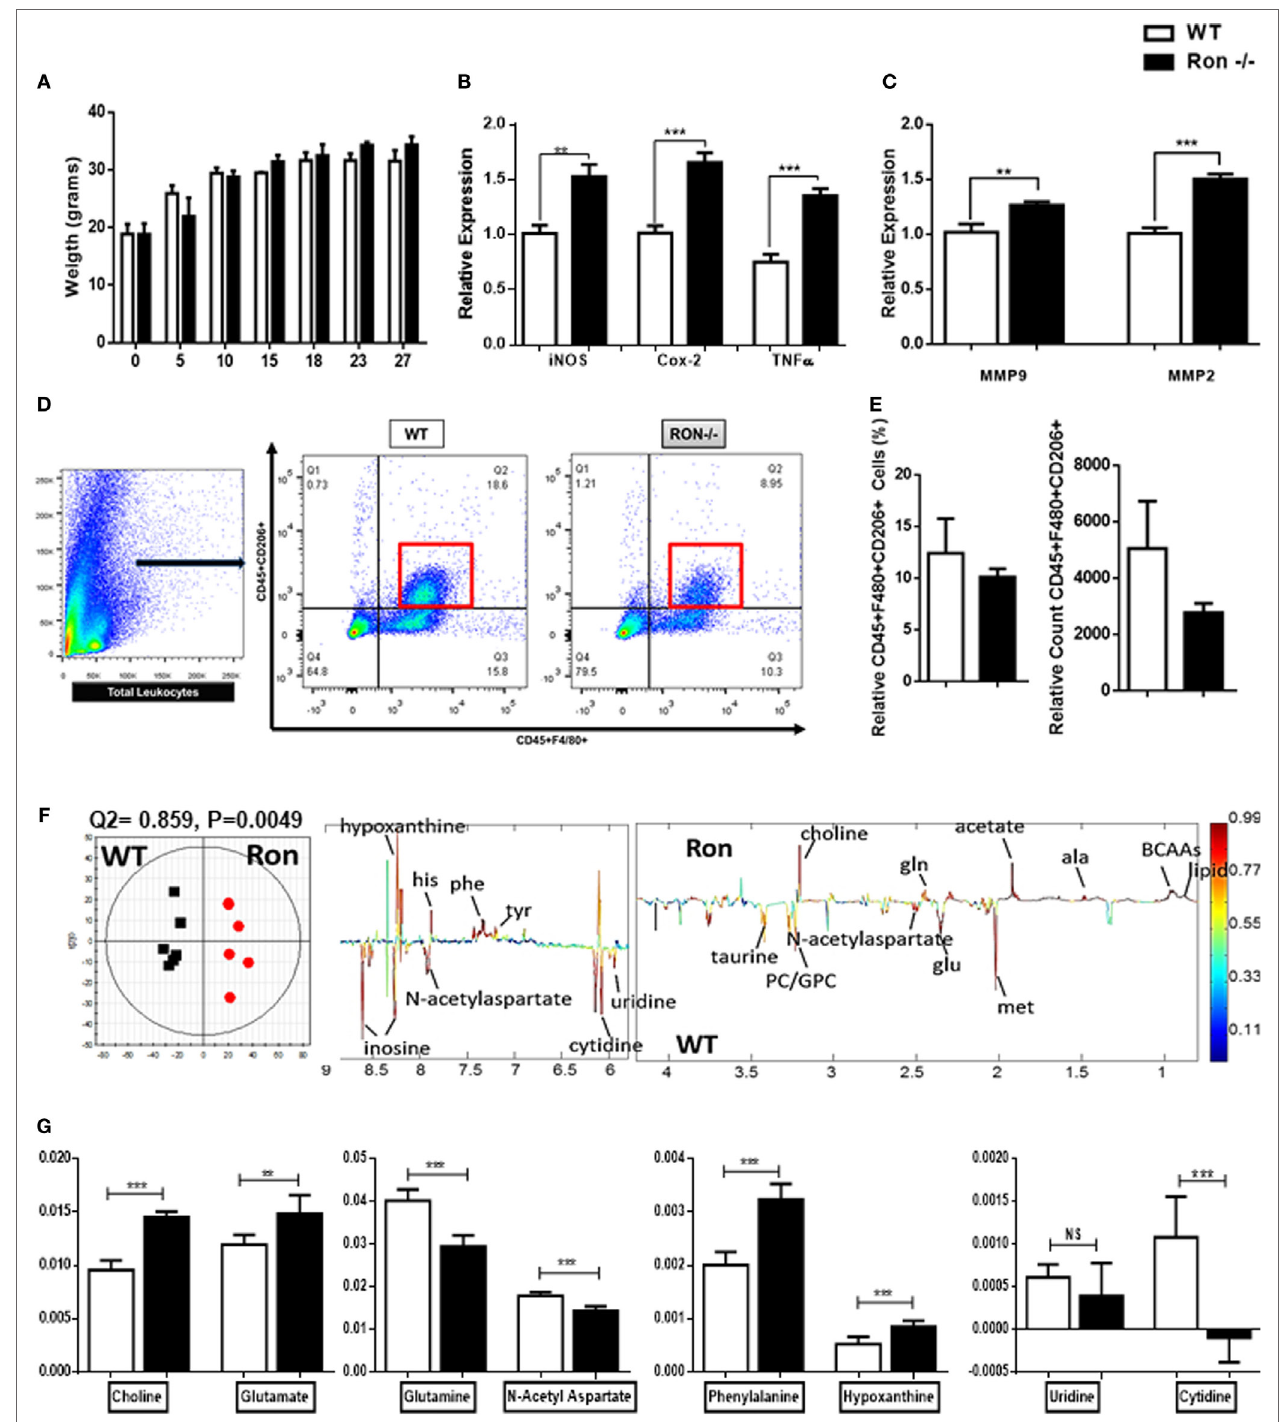
FigUre 2 | Ron promotes homeostasis in the central nervous system (CNS). (a) Weight of wild-type (WT) and Ron − / − mice at 27 weeks of age ( n = 16 mice/ genotype). (B,c) Expression of pro-inflammatory genes and MMPs in the CNS of WT and Ron − / − at 27 weeks of age ( n = 6–8 mice/genotype). (D,e) Immune cells were isolated from the CNS of WT and Ron − / − mice at 27 weeks and the presence of CD45 + F480 + CD206 + macrophages was assessed by flow cytometry ( n = 4 mice/genotype). (F) OPLS-DA scores plot (left) and coefficient plot (right) derived from 1 H NMR spectra of CNS samples from WT and Ron − / − mice at 27 weeks of age. (g) Relative abundance of CNS metabolites measured by 1 H NMR data from WT and Ron − / − mice at 27 weeks of age ( n = 6 mice/genotype) Abbreviations: BCAAs, branched chain amino acids; ala, alanine; met, methionine; glu, glutamate; gln, glutamine; tyr, tyrosine; phe, phenylalanine; his, histidine; MMPs, matrix metalloproteinases (* P < 0.05, ** P < 0.01, *** P < 0.001).